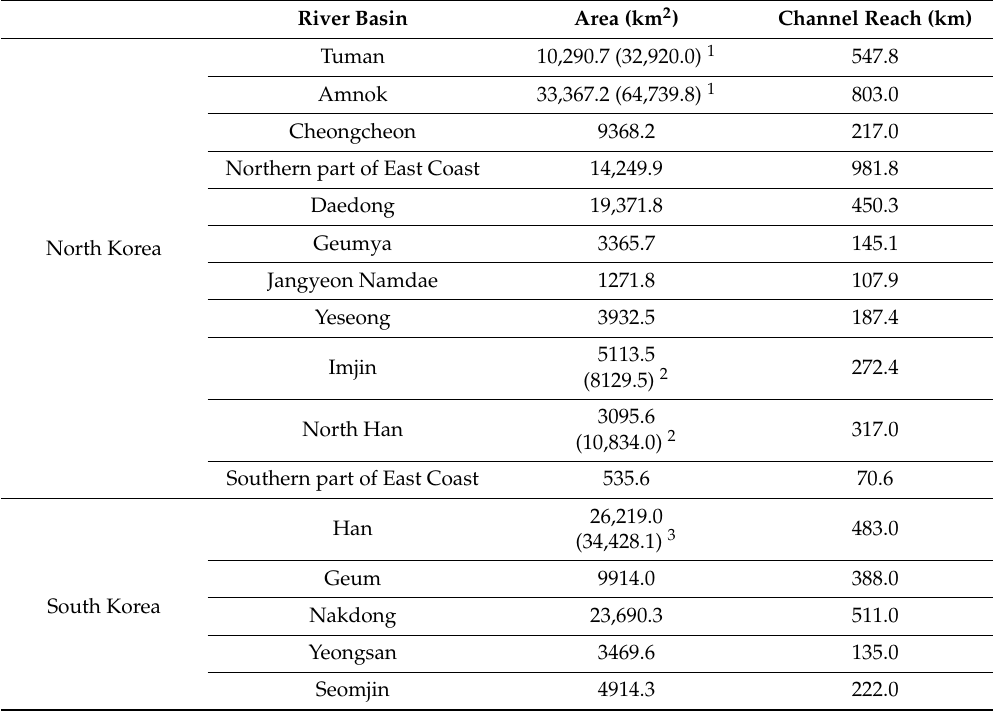
Table 1. Information of major river basins in the Korean